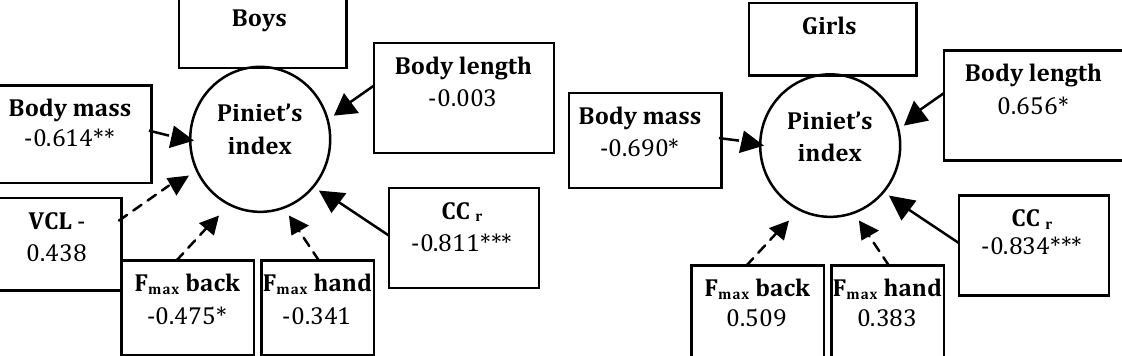
Fig. 3. Interconnection of Piniet’s index with somatologic indicators of students – members of biathlon sport- pedagogic perfection group. CC – chest circumference in rest; r indicators, which compose index; indicators, which influence on index;